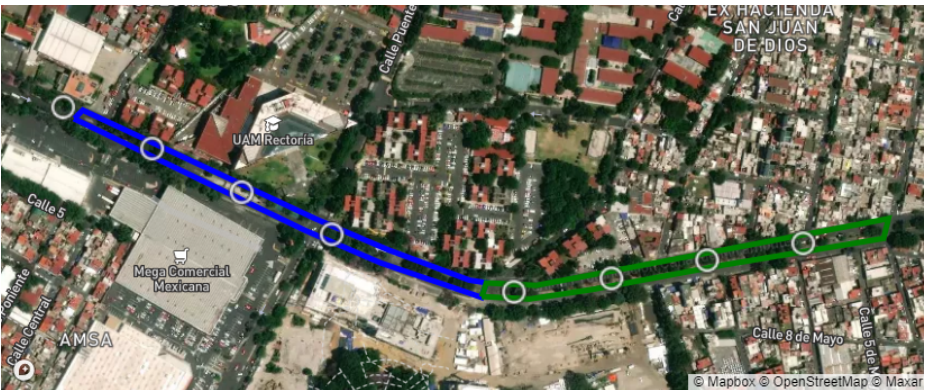
Figure 4. APs marks on the first route of the experiment.